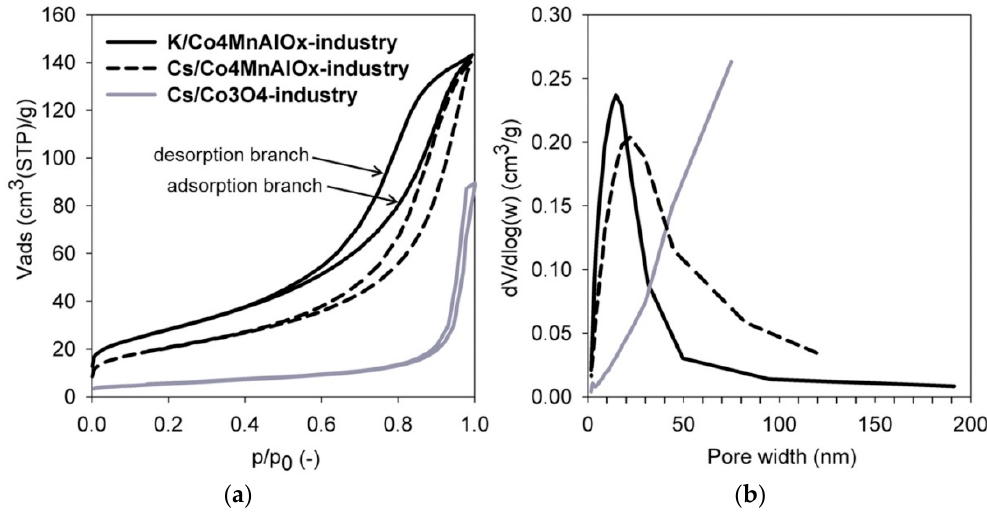
Figure 4. ( a ) Measured nitrogen adsorption–desorption isotherms and ( b ) evaluated pore-size distributions of commercially prepared catalysts.